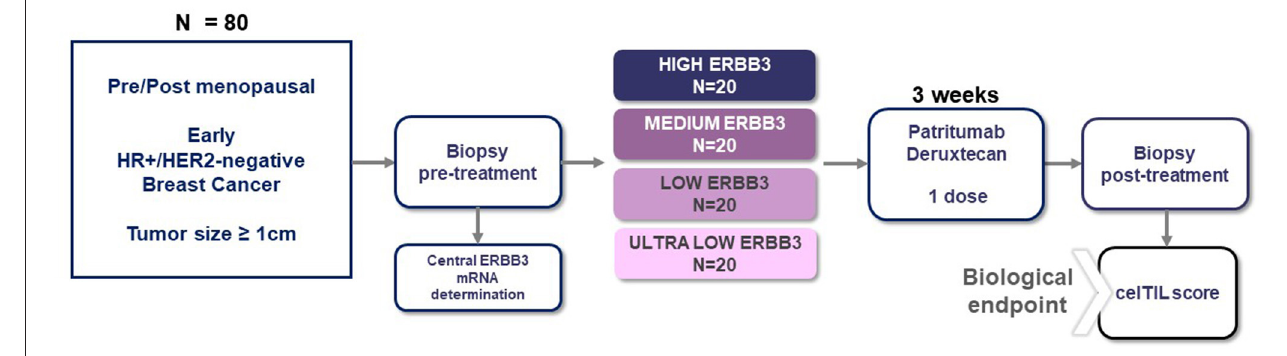
FIGURE 1 | TOT-HER3 trial design.